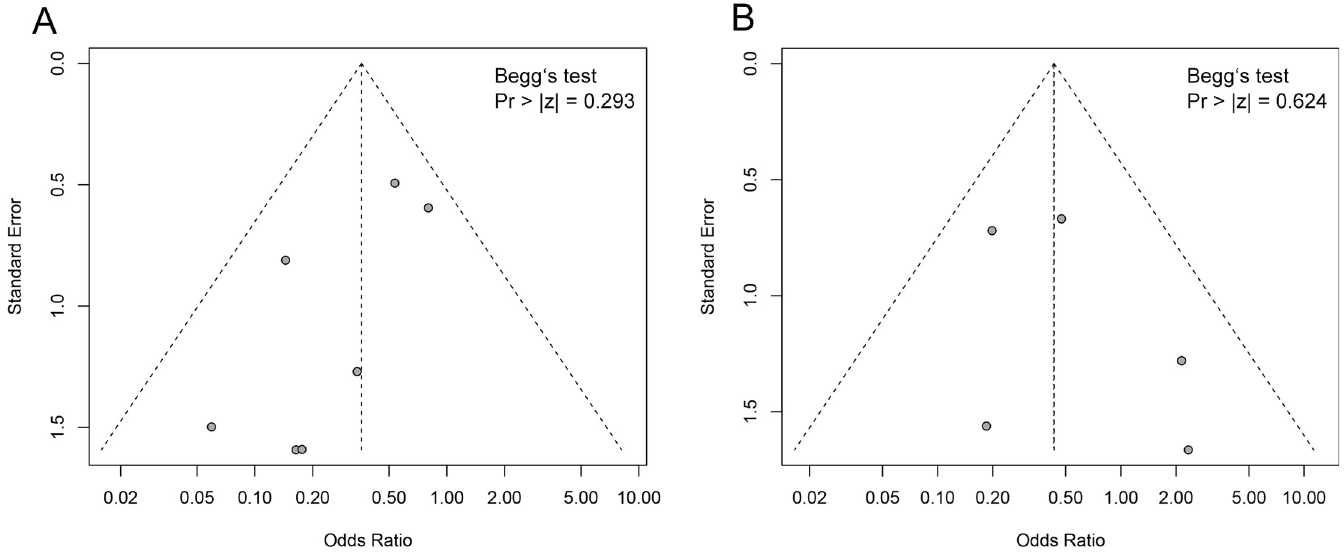
Fig 6. Funnel plots of gastrointestinal tract hemorrhage (A) and surgical site hemorrhage (B).